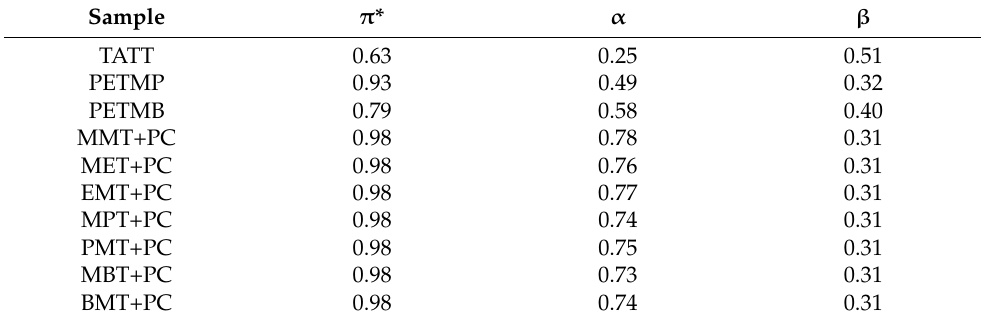
Table 2. Solvatochromic parameters (Kamlet–Taft): α —ability to hydrogen bond donation; β —hydrogen bonding accepting ability; π *—the polarizability/dipolarity determined for monomers and mixtures of the synthesized triazolium ionic liquids with